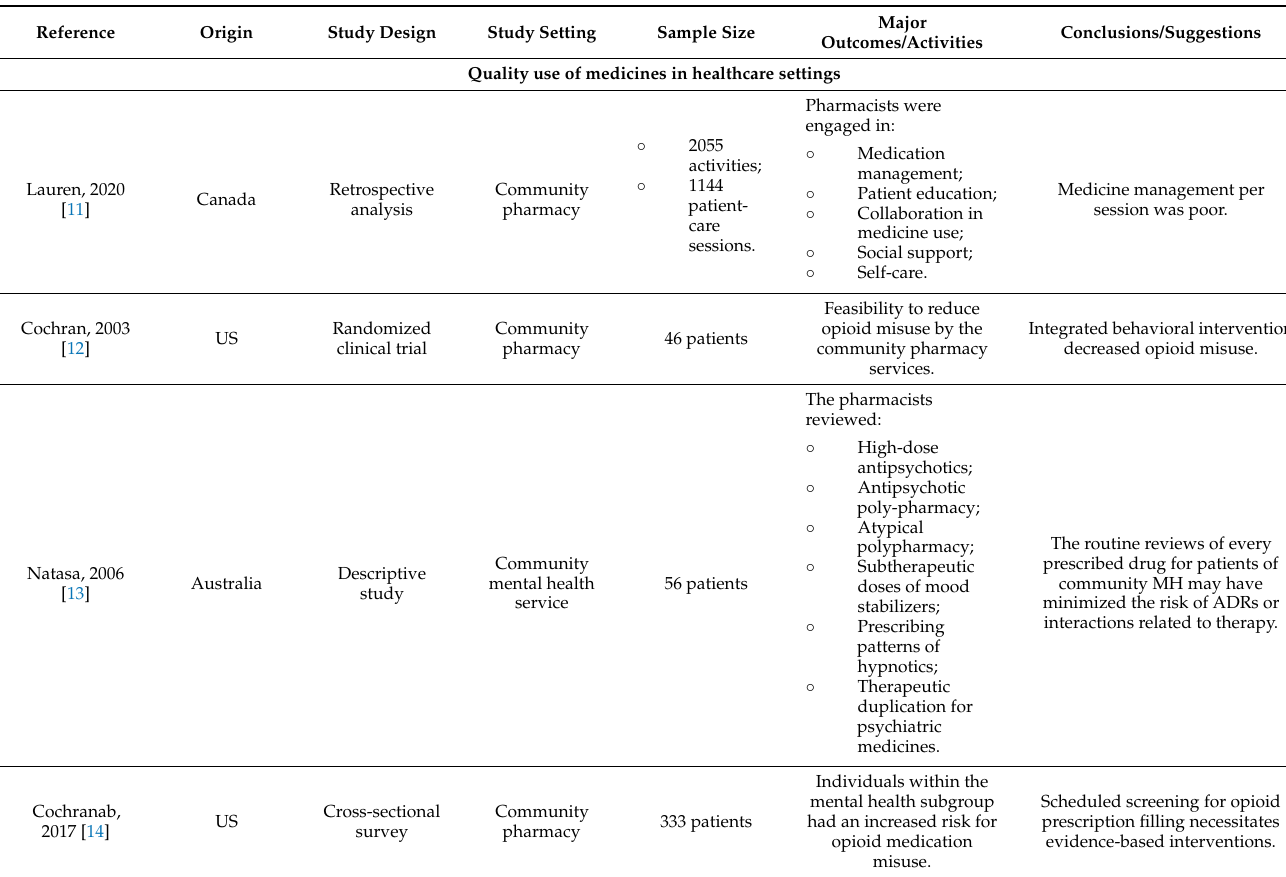
Table 2. Summary of studies’ characteristics (conventional